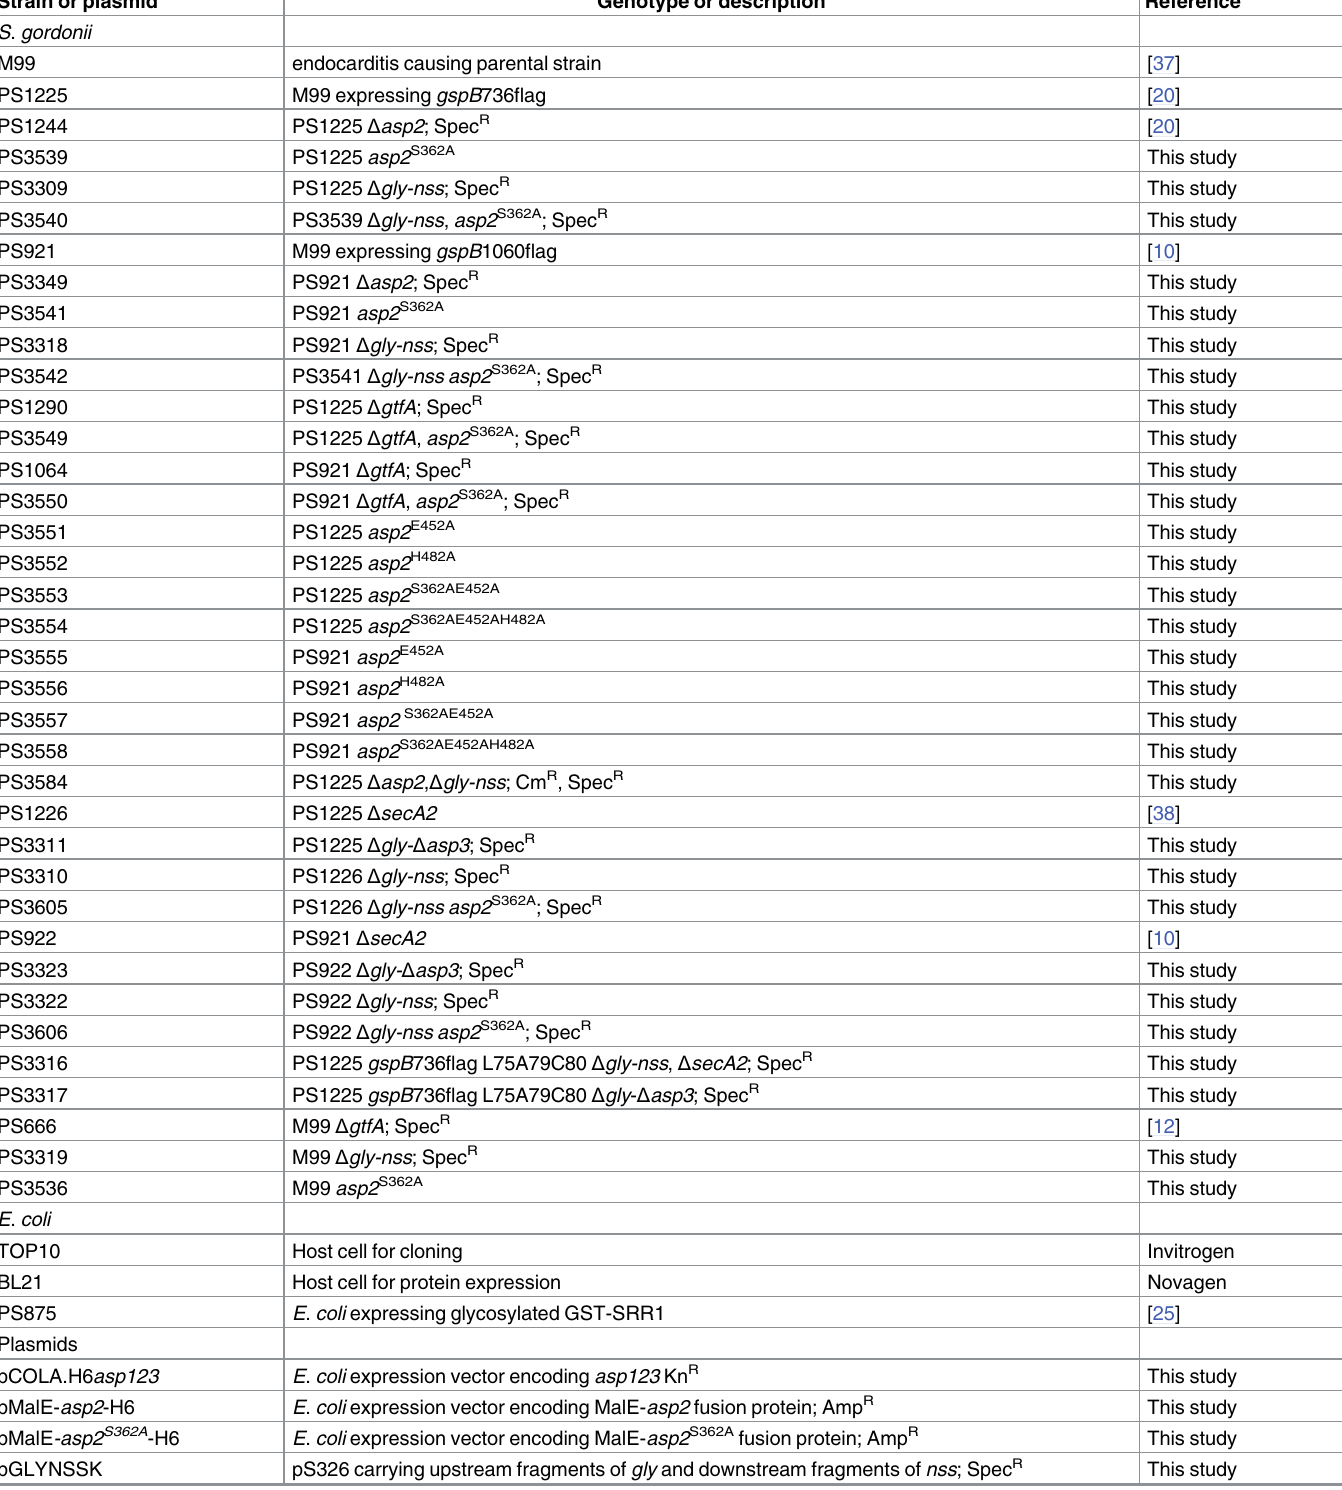
Table 2. Bacterial strains and plasmids. Strain or